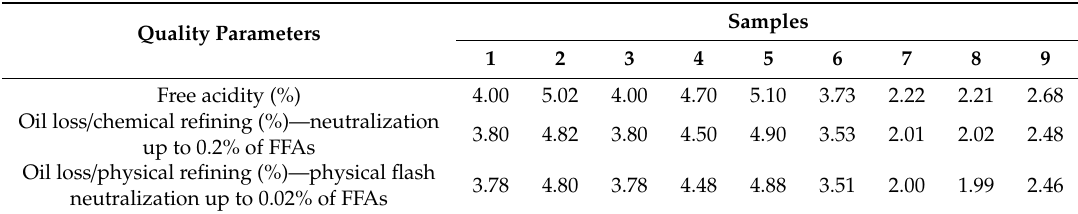
Table 4. Oil loss in the refining